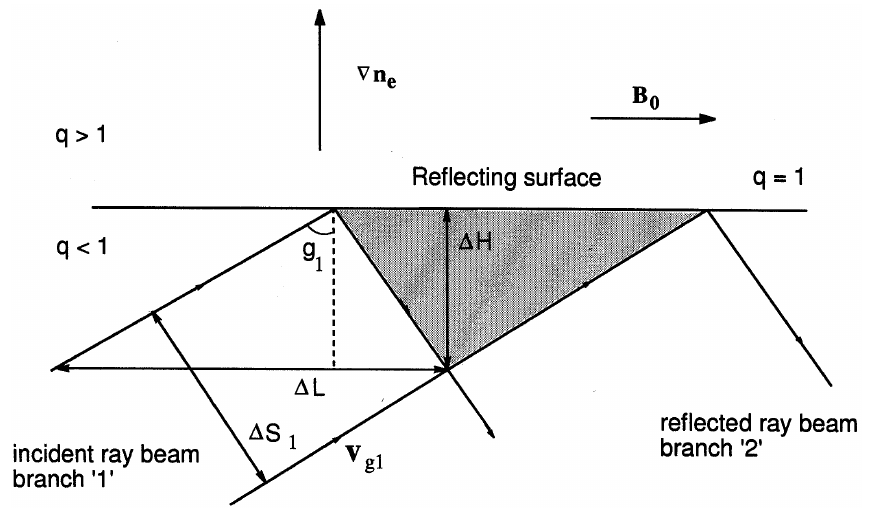
Fig. 3. Outlines of the reflection process showing the conversion of the quasi-longitudinal electromagnetic whistler branch ‘1’ (incident ray beam) to the quasi-resonant electrostatic whistler branch ‘2’ (reflected ray beam), respectively, (see also Fig. 1); the existence of a plasma density gradient ∇ n e across the ambient magnetic field B 0 provides geometrical optics reflection of the incident ray beam at the reflecting surface where q = 1 (see also Eq. 22). The region represented in gray is the interference zone between the incident and the reflected waves. The distance 1 H represents the extension of the wave field interference pattern across the ambient magnetic field, whereas 1 L and 1 S 1 = 1 L cos g 1 are the cross sections of the incident ray beam along B 0 and transverse to the incident group velocity v g 1 ,